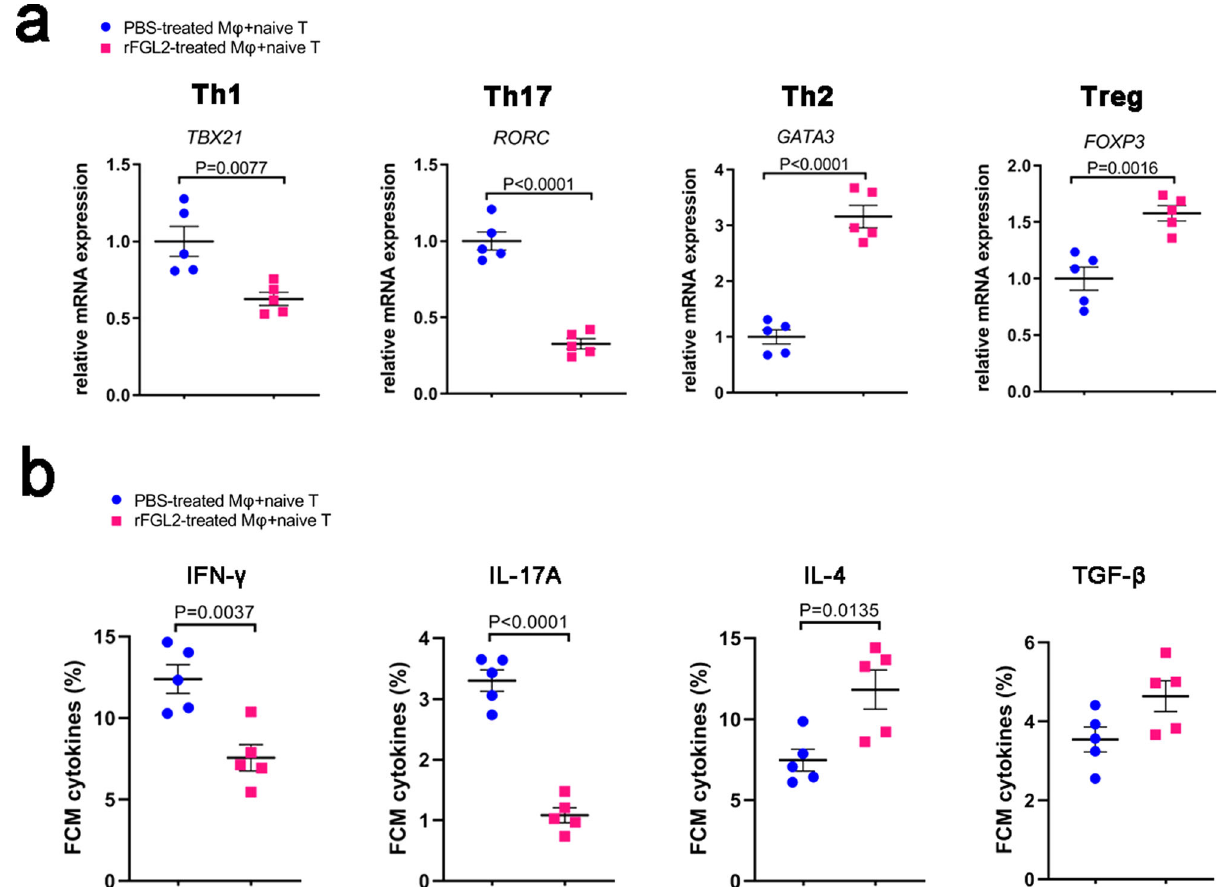
Fig. 9 FGL2-polarized pro-repair macrophages induced Th2 and Tregs differentiation. FGL2-treated macrophages were cocultured with naive T cells at a ratio of 1:4, mRNA and cytokines secretion levels were determined by qRT-PCR ( a ) and FCM ( b ). Data represent the mean value ± SEM of fi ve individual experiments ( n = 5).